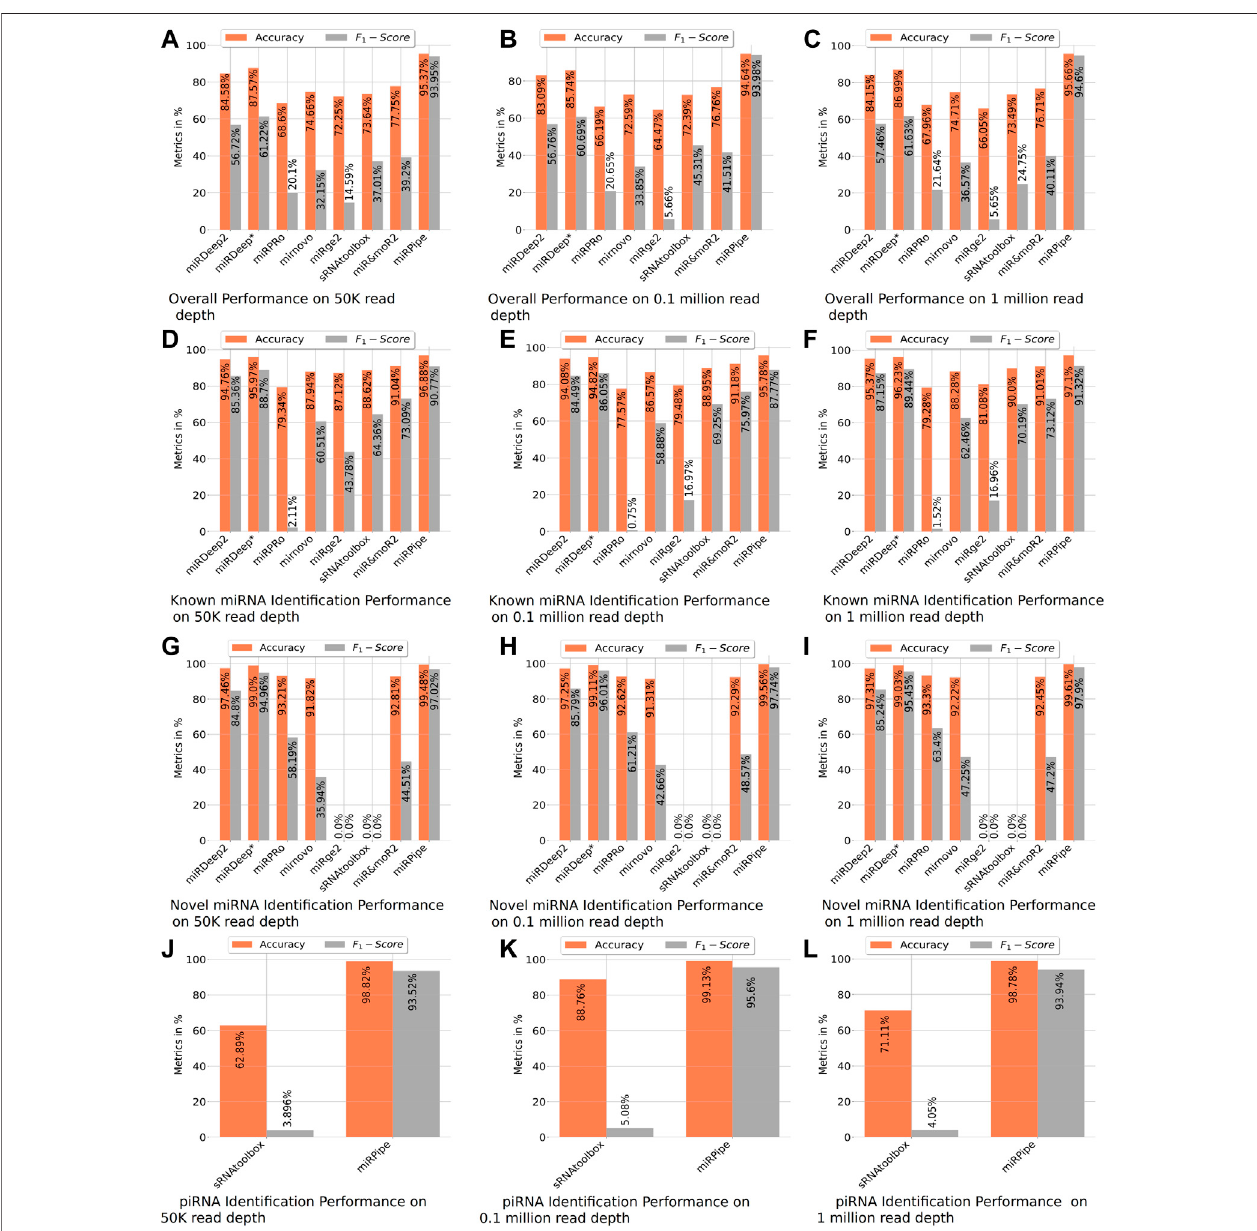
FIGURE 4 | Benchmarking of miRPipe with the existing pipelines on synthetic data. Averaged results are reported over 10 FASTQ fi les generated for each read depth of50 k,0.1 million,and 1million reads. Theoverallperformanceofallexisting pipelines areshown in (A – C) .All thepipelinesare benchmarked againstmiRPipefor known miRNA in (D – F) and for novel miRNAs in (G – I) . Among the existing pipelines, only sRNAtoolbox identi fi es piRNA and hence, comparison results of miRPipe for piRNA are compared with only sRNAtoolbox in (J – L)